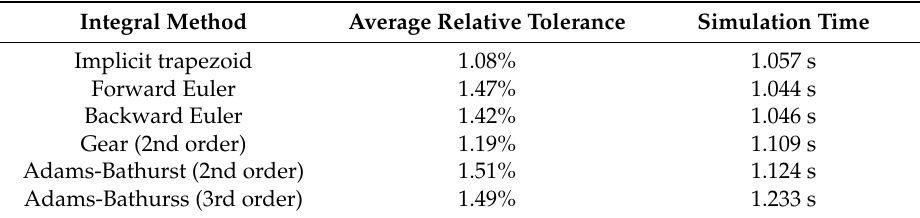
Table 6. Influence of the integral method on the